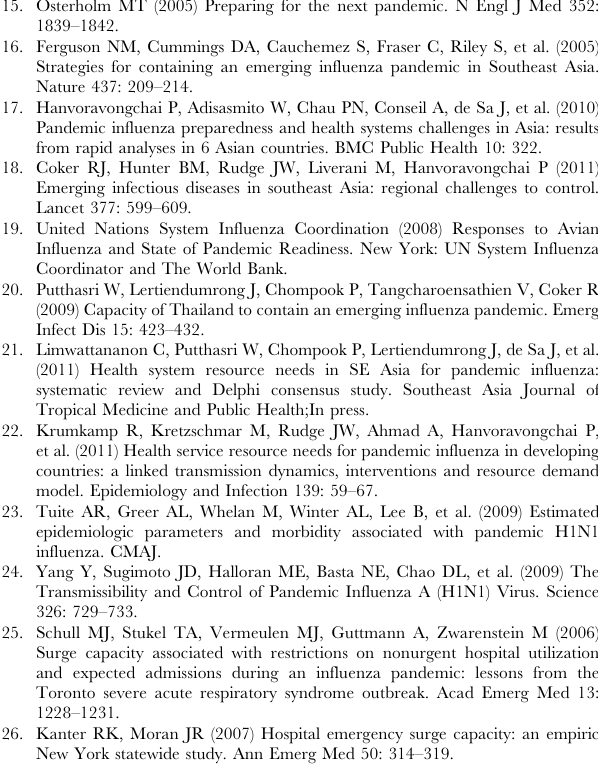
Figure S1 Variation in estimated resource capacities across provinces within each territory for the modeled pandemic scenario. Figure S2 Geographical distribution of estimated avoid- able deaths due to resource gaps for a modeled pandemic influenza scenario. Figure S3 Estimated avoidable mortality rates by resource gap when oseltamivir usage is not restricted to severe influenza cases. Figure S4 Sensitivity of model outputs to changes in pandemic severity. Text S1 Mathematical model structure and assump- tions. Table S1 Model parameters and